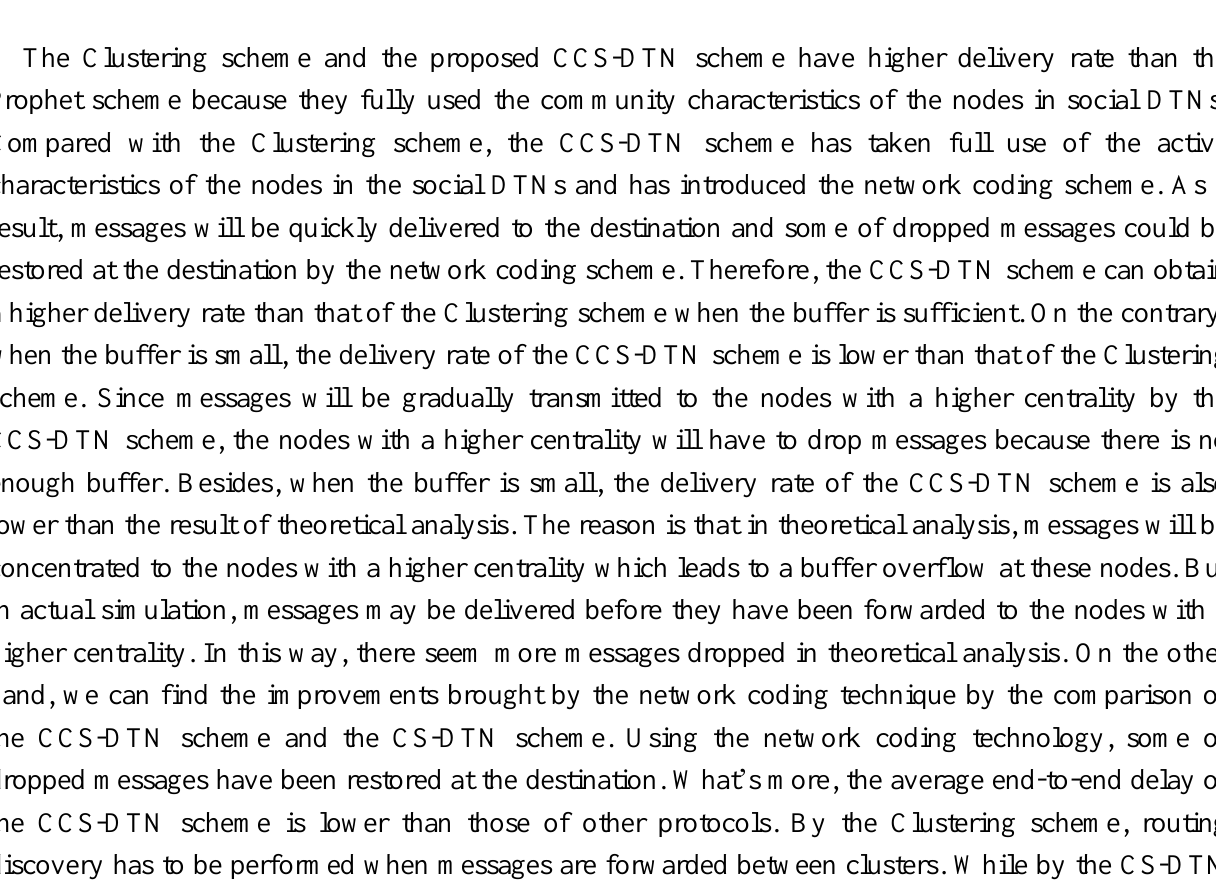
Figure 6. Impact of Queue Size on Average End-to-End